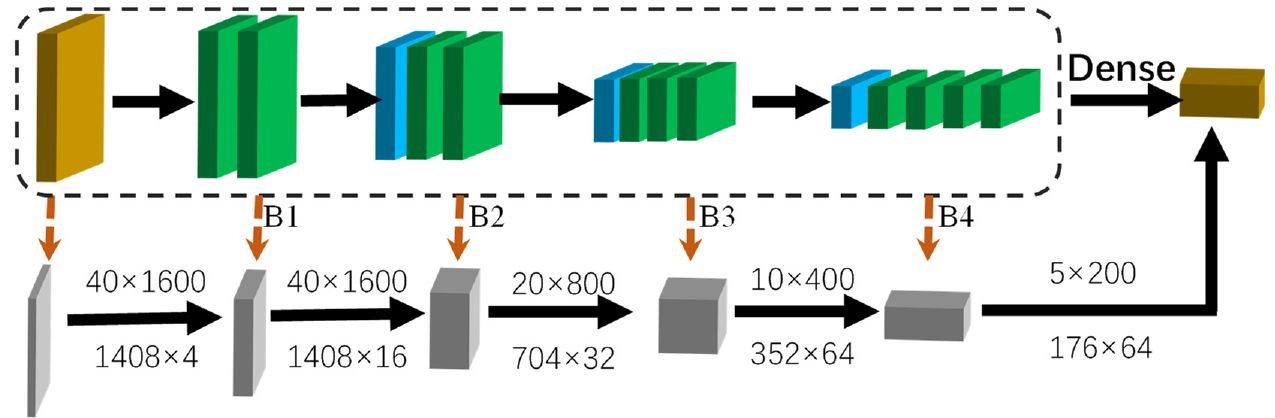
Figure 4. The structure of the 3D backbone module. The first orange box converts voxel features into 4D sparse tensors. The green boxes are submanifold convolutional layers. The blue boxes are sparse convolution with stride = 2.